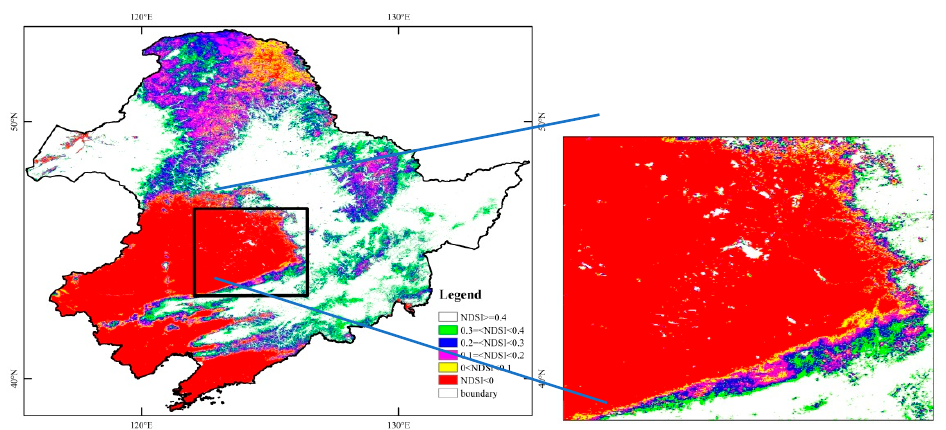
Figure 12. Raw NDSI distribution of images on 16 March 2018. It is difficult to discriminate ice clouds from snow due to their similar spectral charac- teristics. However, it is feasible to discriminate them according to the difference in pixel stability. In Figure 11b, some likely ice clouds are marked in the blue box. These pixels seem to be snow in the false-color image in Figure 8b and were not marked as clouds in the NDSI_Snow_Cover in Figure 9b. On the one hand, these pixels may be ice clouds because their NDSI variance is high; on the other hand, they may be snow, and the high NDSI variance is caused by clouds passing this region before or after Terra passed.